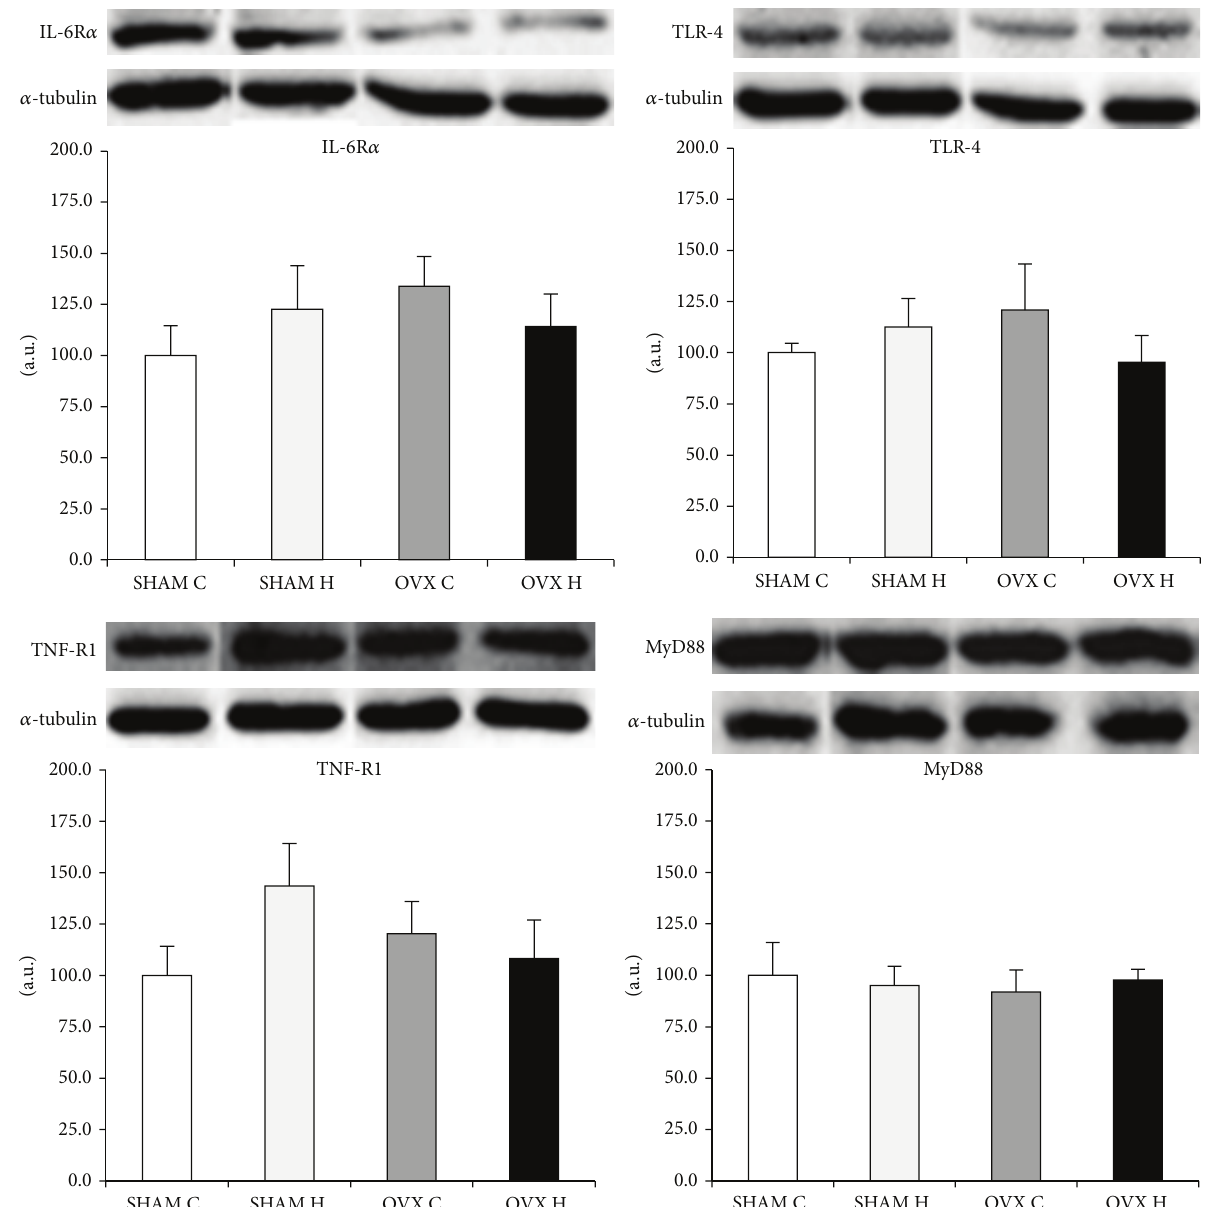
Figure 8: Mesenteric adipose tissue IL-6R 𝛼 , TNF-R1, TLR-4, and MyD88 protein content: (SHAM C) sham group treated with control diet; (SHAM H) sham group treated with hyperlipidic diet; (OVX C) ovariectomized group treated with control diet; (OVX H) ovariectomized group treated with hyperlipidic